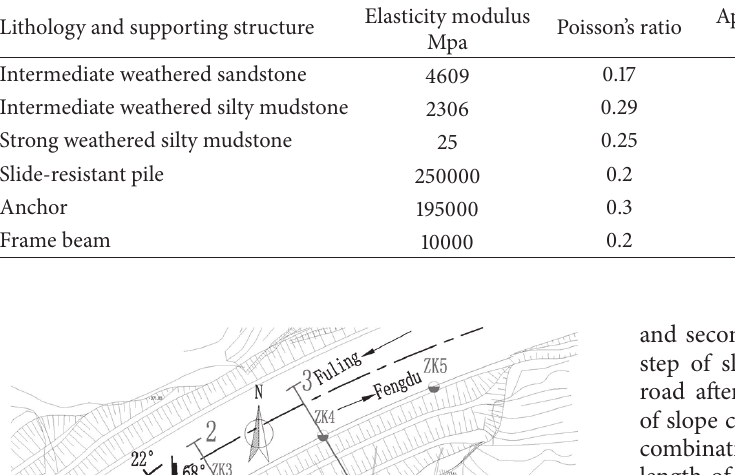
Table 1: Lithology and supporting structure calculation parameters.